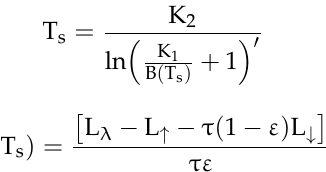
the street view image street view